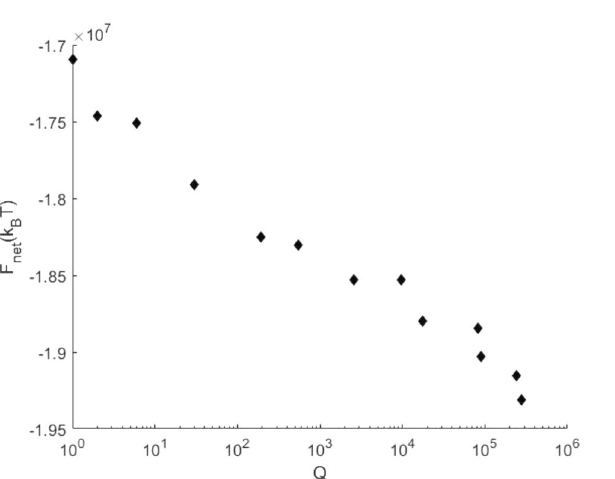
Figure 7. The total energy of the optimal irregular configuration (blue circles) and of the hexagonal configuration with symmetric junctions (red squares) as functions of the number of junctions. The number of sources, N M , are equal for the hexagonal and irregular networks. The solid line shows the results of calculations according to the approximate analytical equation (Eq. 13) which neglects the contributions of the edges, connected to the boundary. The parameter values used are: l c γ 340 10 3 k B T µm −1 ( B ). = ×